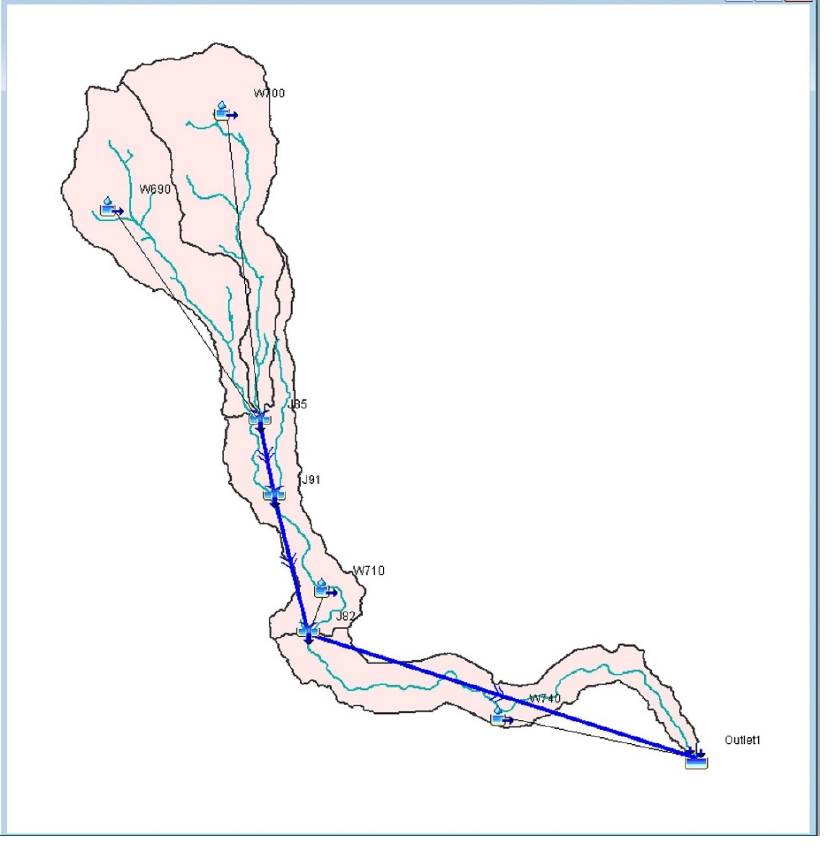
Figure 10. The workspace of HEC-HMS software showing the imported base model using ArcHy- dro and HEC-GeoHMS extensions in ArcGIS. and HEC-GeoHMS extensions in